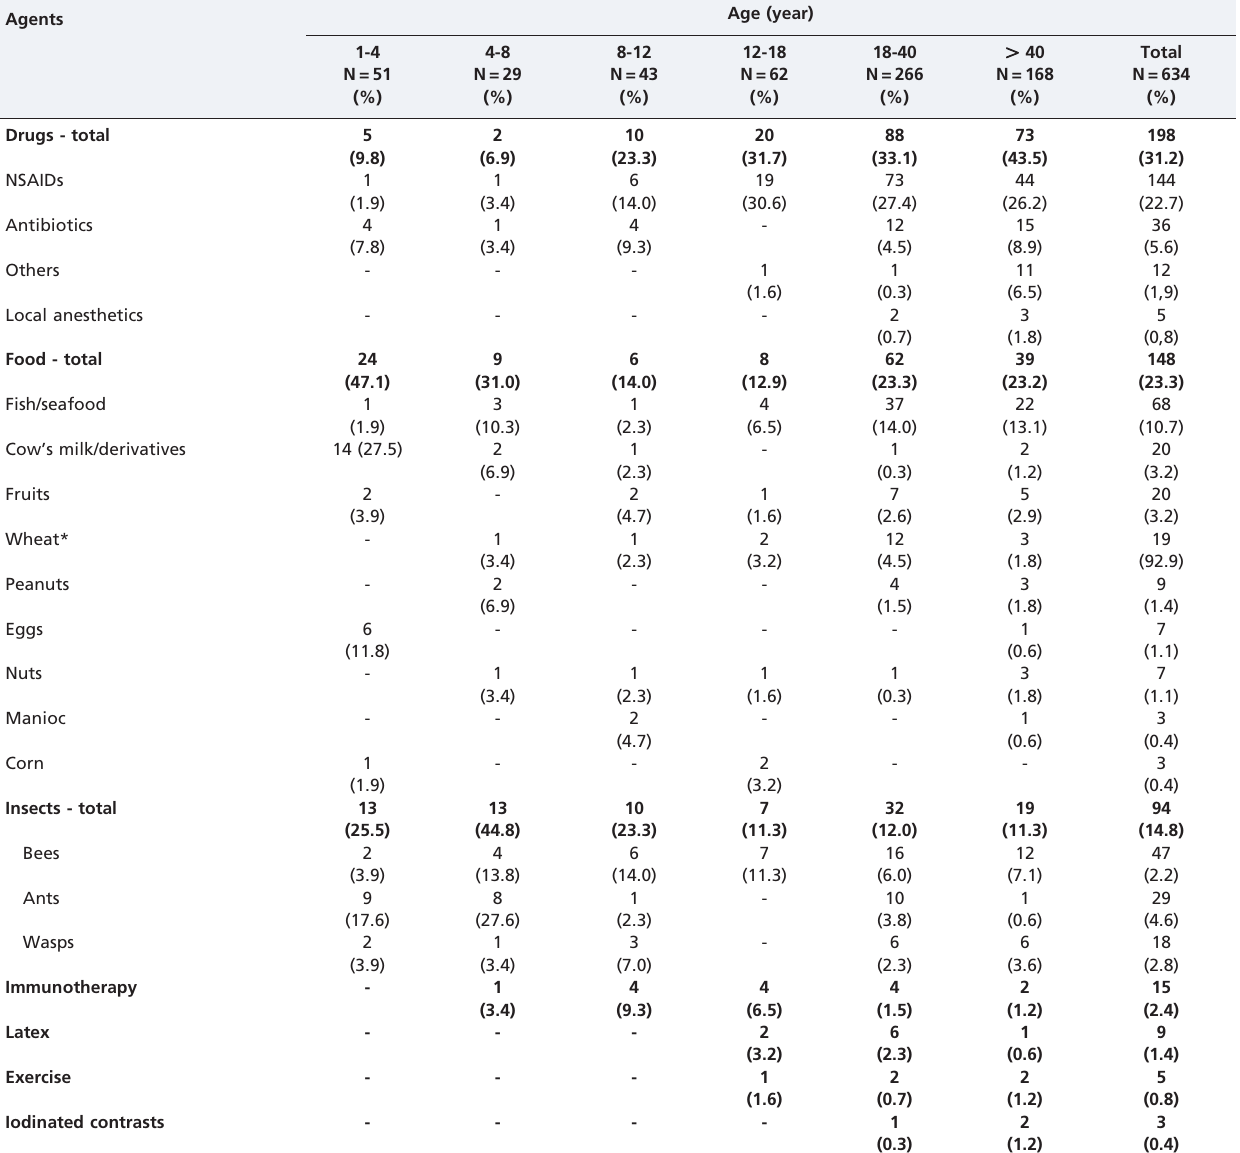
Table 1 - Main triggering agents for severe allergic reactions, according to the age of patients, registered in the Online Latin American Survey on